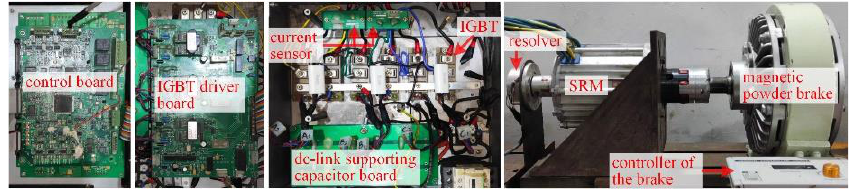
Figure 21. Experimental platform.